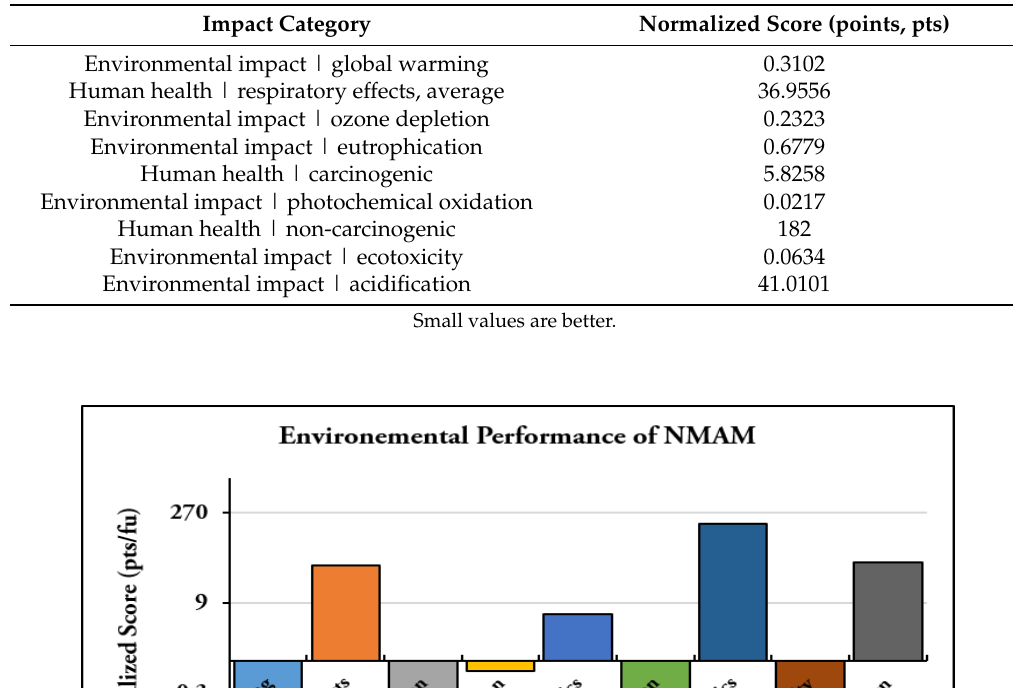
Table 6. Normalized score per FU of the impact categories for NMAM.